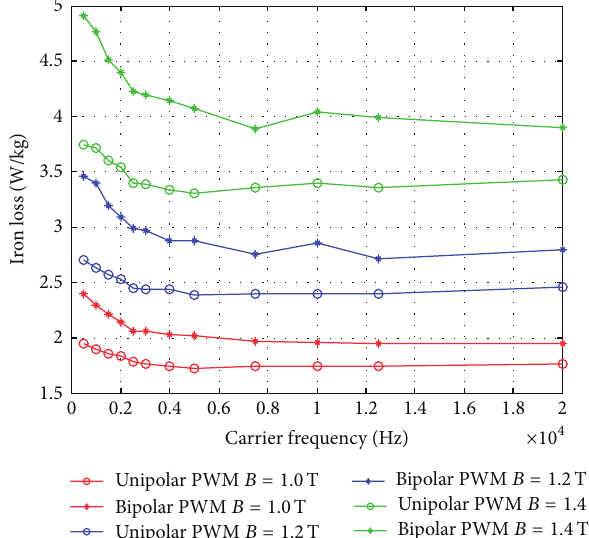
Figure 25: Iron loss versus carrier frequency for bipolar and unipolar PWM at different flux densities measured using the new toroidal